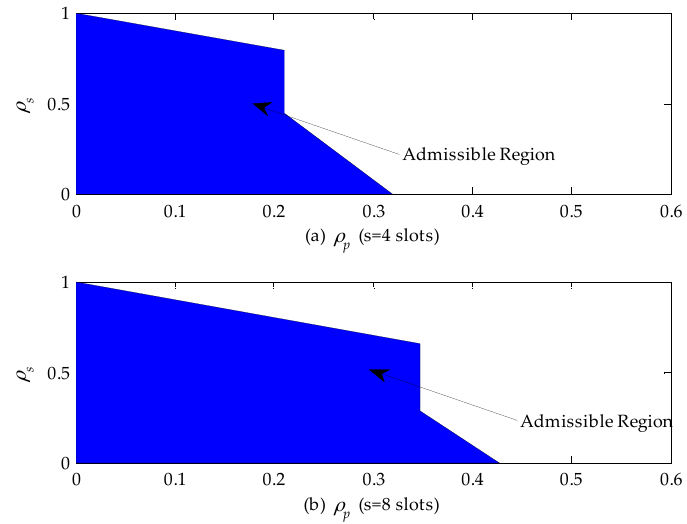
Figure 9. The admissible region of a cognitive radio (CR) network when the service time of the primary connection follows the exponential distribution: ( a ) the maximum allowable delay is set to be four slots; and ( b ) the maximum allowable delay is set to be eight slots.